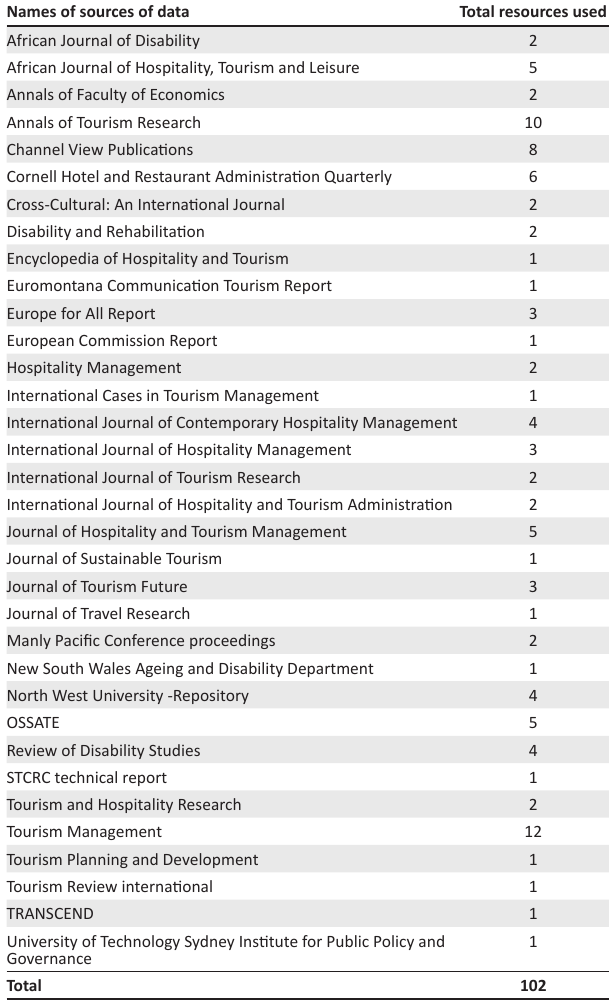
TABLE 3: Sources of data used for this study (in alphabetical